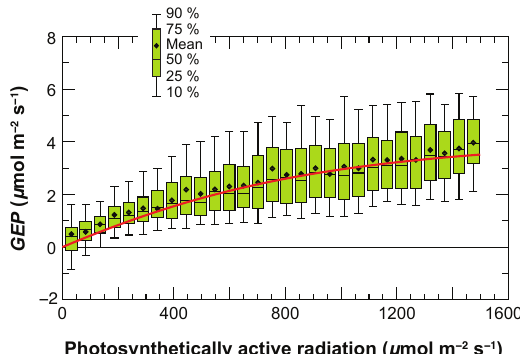
Figure 5. Relationship between R e (nighttime 30min CO 2 flux measurements) and T s , 5cm during the entire study period. The u ∗ threshold was 0.08ms − 1 . The fitted curve is a logistic relationship following Eq. (1). T s , 5cm was binned for 32 classes from minimum of T s , 5cm to maximum of T s , 5cm . See Fig. S5 for seasonal differ- ences. Negative R e values were caused by measurement uncertain- ties.